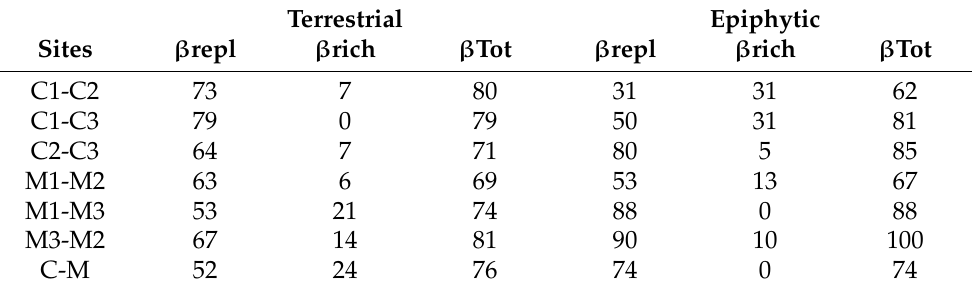
Table 2. Beta diversity of terrestrial and epiphytic mosses between conserved and managed forests. Species replacement ( β repl), differences in richness ( β rich), and total beta diversity ( β Tot) are expressed in